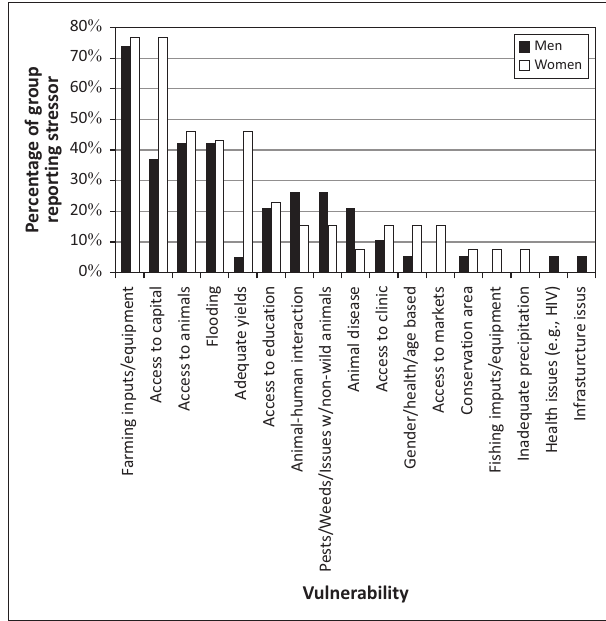
FIGURE 18: The gendered vulnerability context of Group C.